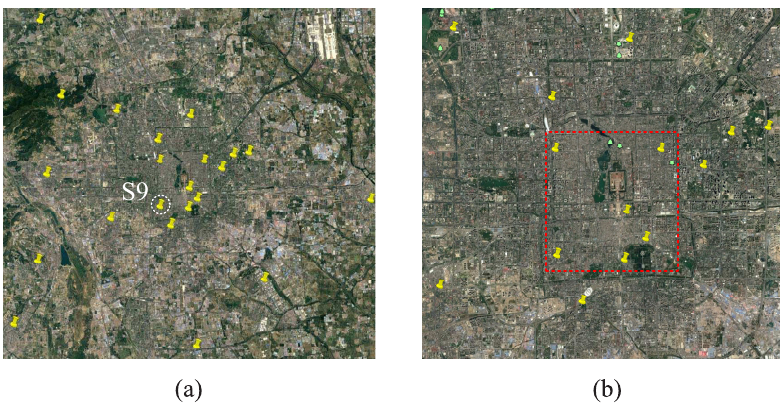
Figure 12. ( a ) Air quality monitoring stations in Beijing viewed from Google Earth; ( b ) The selected monitoring area within 2th ring road of Beijing.